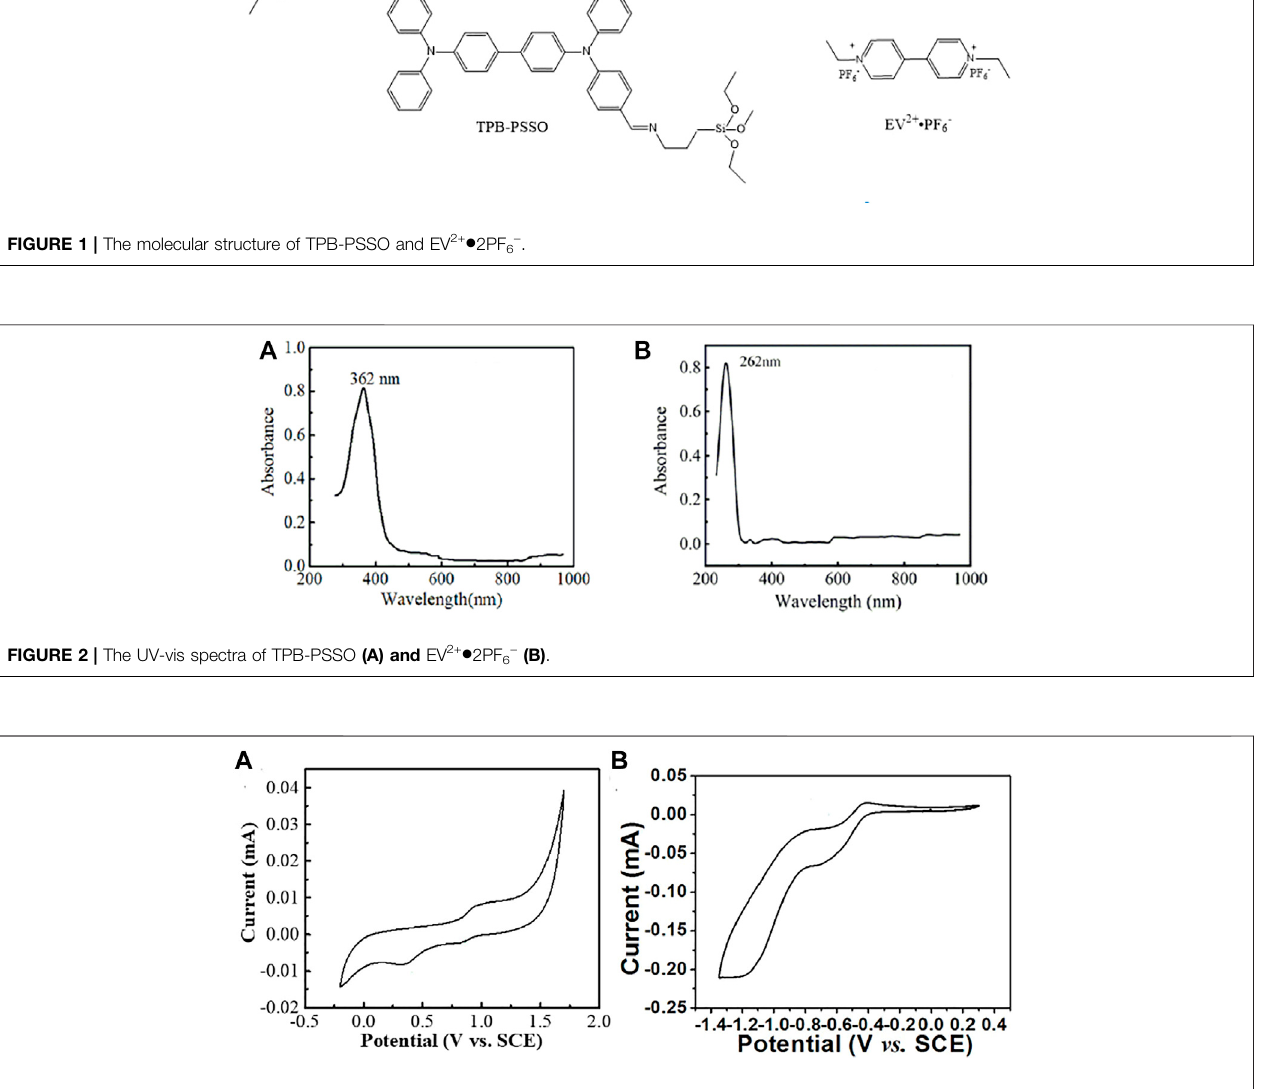
FIGURE 3 | The CV curve of TPB-PSSO (A) and EV 2+